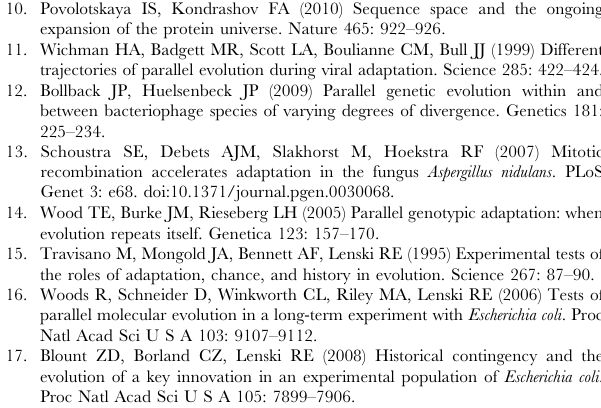
Table S1 Overview of all synonymous and non-synonymous mutations found in the selected lines presented in Figure 2, Figure 3, Figure 4, and Figure 5 of the main text. Mutations